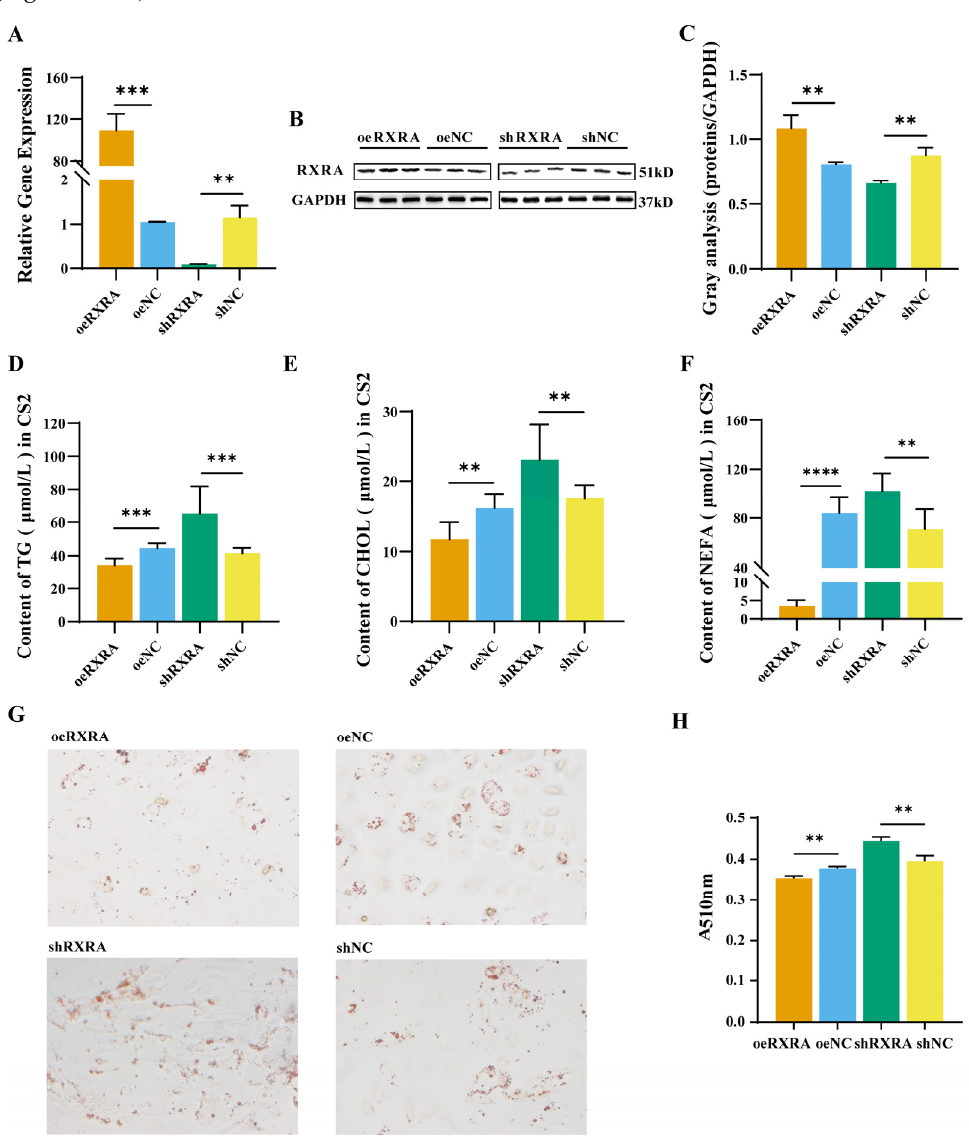
Figure 2. RXRA gene inhibits the contents of TGs, CHOL, and NEFAs in myoblasts. ( A ) Relative mRNA expression levels of RXRA in CS2 cells transfected with oeRXRA, oeNC, shRXRA, and shNC. ( B ) The indicated protein levels were detected by western blot analysis. ( C ) The relative fold change in RXRA/GAPDH as determined by western blotting was quantified through a gray scale scan. TG ( D ), CHOL ( E ), and NEFA ( F ) contents in CS2 cells transfected with overexpression vectors oeRXRA and oeNC and short hairpin (interference) vectors shRXRA and shNC. ( G ) Lipid droplets in CS2 cells. The images were taken under 20 × . ( H ) Quantitative results of lipid droplets in CS2 cells. The data were reported as the means ± SD on the basis of three experiments. ** indicates p < 0.01, *** indicates p < 0.001, and **** indicates p <